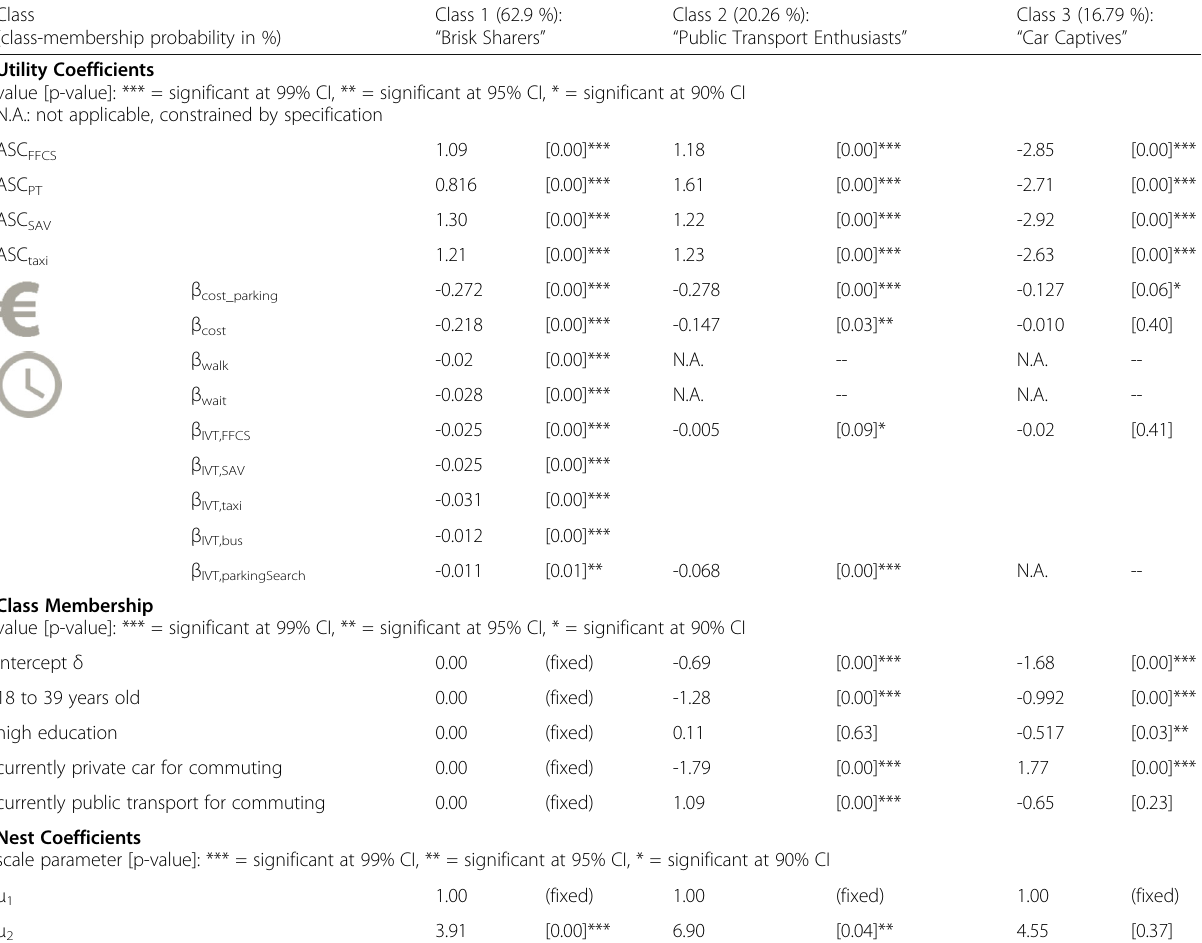
Table 3 Estimated coefficients, class membership parameters and nesting parameters